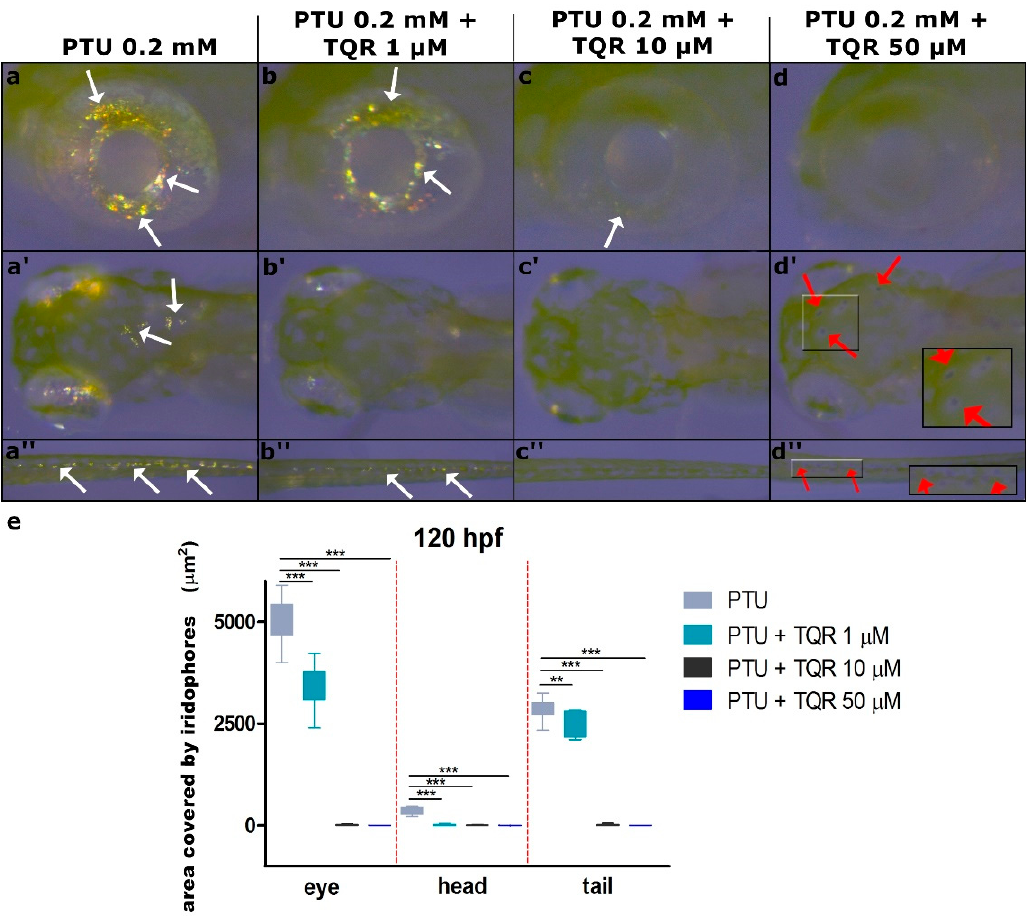
Figure 5. Dose-dependent decrease in zebrafish iridophore pigmentation following the exposure to the mixture of 0.2 mM 1-phenyl-2-thiourea (PTU) and increasing concentrations of tariquidar (TQR) at 120 h post fertilization (hpf). A set of photographs showing lateral and dorsal views of 120 hpf zebrafish larvae exhibiting effects of 68 h PTU + TQR exposure on the iridophore pigmentation within the eye, dorsal head, and tail in four experimental groups: ( a , a’ , a” ) exposed to PTU 0.2 mM, ( b , b’ , b” ) exposed to PTU 0.2 mM + TQR 1 µ M ( c , c’ , c” ) exposed to PTU 0.2 mM + TQR 10 µ M, and ( d , d’ , d” ) exposed to PTU 0.2 mM + TQR 50 µ M. PTU treatment resulted in melanophore disappearance with no influence on the iridophores ( a , a’ , a” ; white arrows). Co-treatment with 1 µ M TQR caused a slight reduction in the area covered with the iridophores; however, they were still well visible, mostly within the eye and tail ( b , b” ) (white arrows). In the 10- µ M TQR co-treated group, only single iridophores were visible within the eye ( c ) (white arrow), while in the area of the dorsal head and tail they disappeared entirely ( c’ , c” ). The addition of 50 µ M TQR to the PTU solution resulted in a complete depletion of the iridophores within all areas investigated ( d , d’ , d” ); however, small and faint melanophores were detectable (red arrows) ( d’ , d” ). ( e ) A graph presenting the area covered by iridophores ( µ m 2 ) measured at 120 h post fertilization (hpf) within the eye, dorsal head, and tail (Kruskall–Wallis, GraphPad Prism 5, *** p < 0.001, ** p <